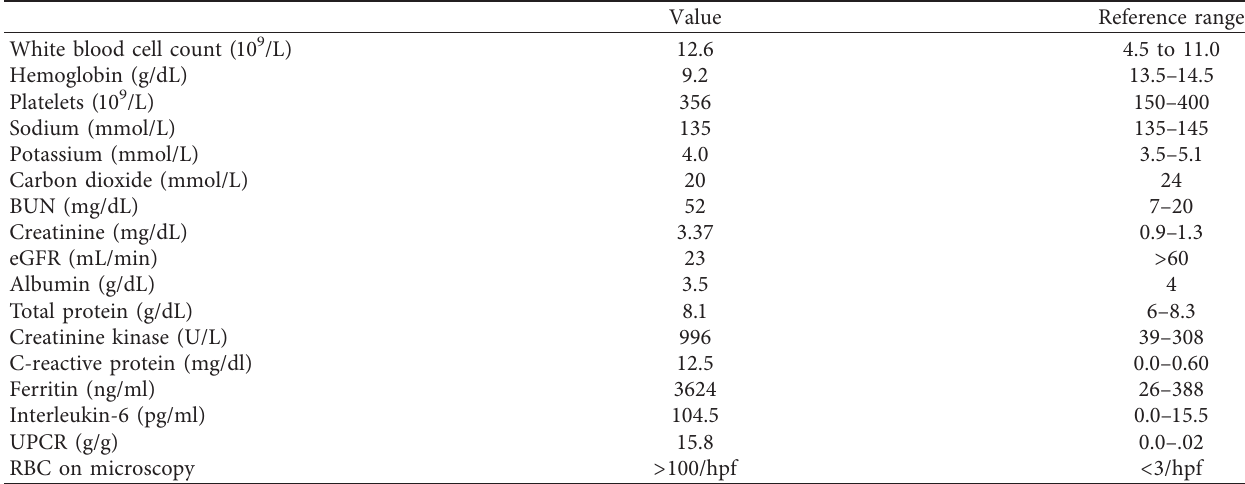
Table 1: Admission labs with normal reference value.